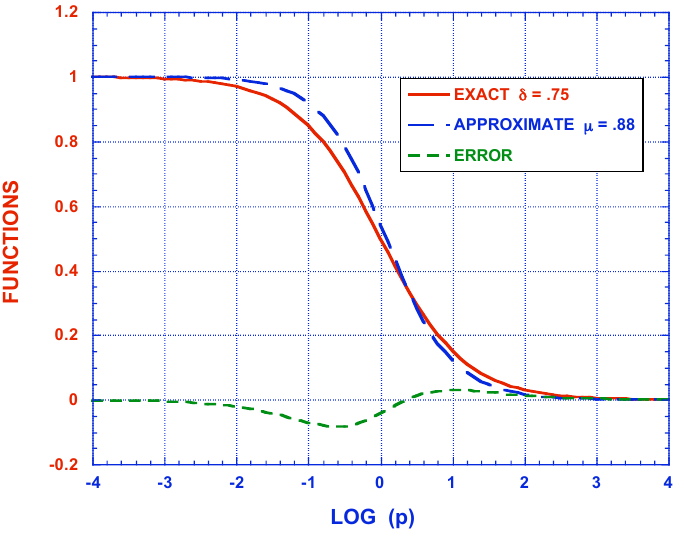
Figure 8. Exact and approximate FD.